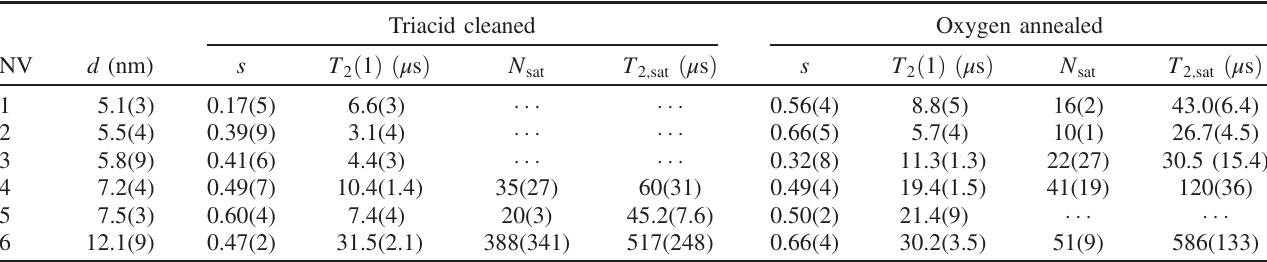
TABLE I. Fit parameters for the dynamical decoupling scaling shown in Fig. 10.